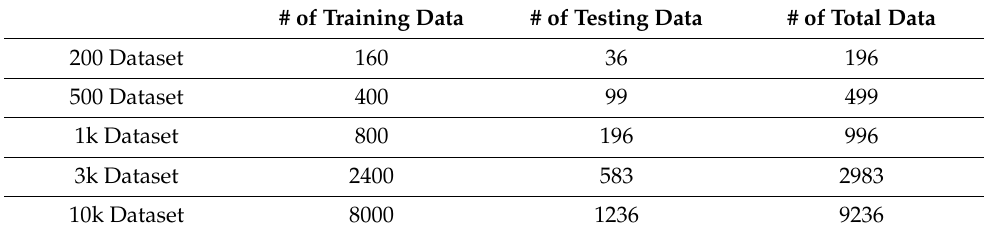
Table 4. The number of training data and testing data in the dataset used in the